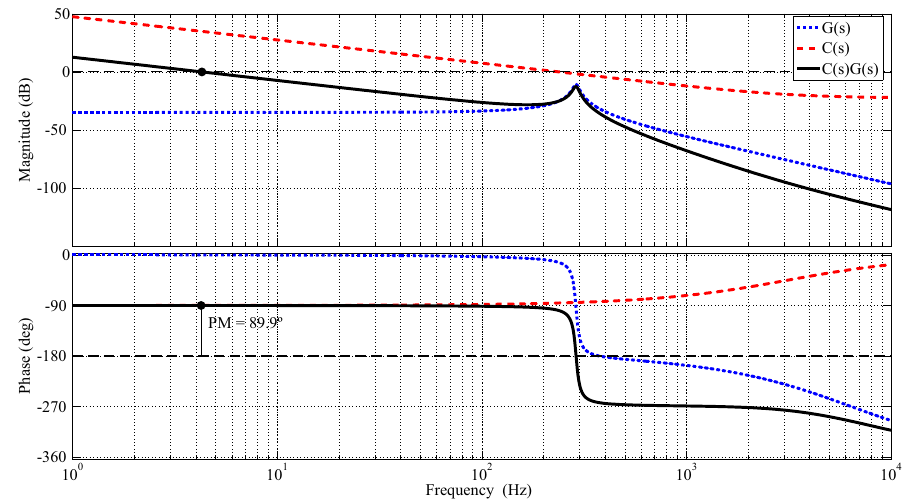
Figure 7. Frequency response of the plant, G ( s ) , the controller, C ( s ) , and the open-loop transfer function, C ( s ) G ( s ) , for the reactive power control.